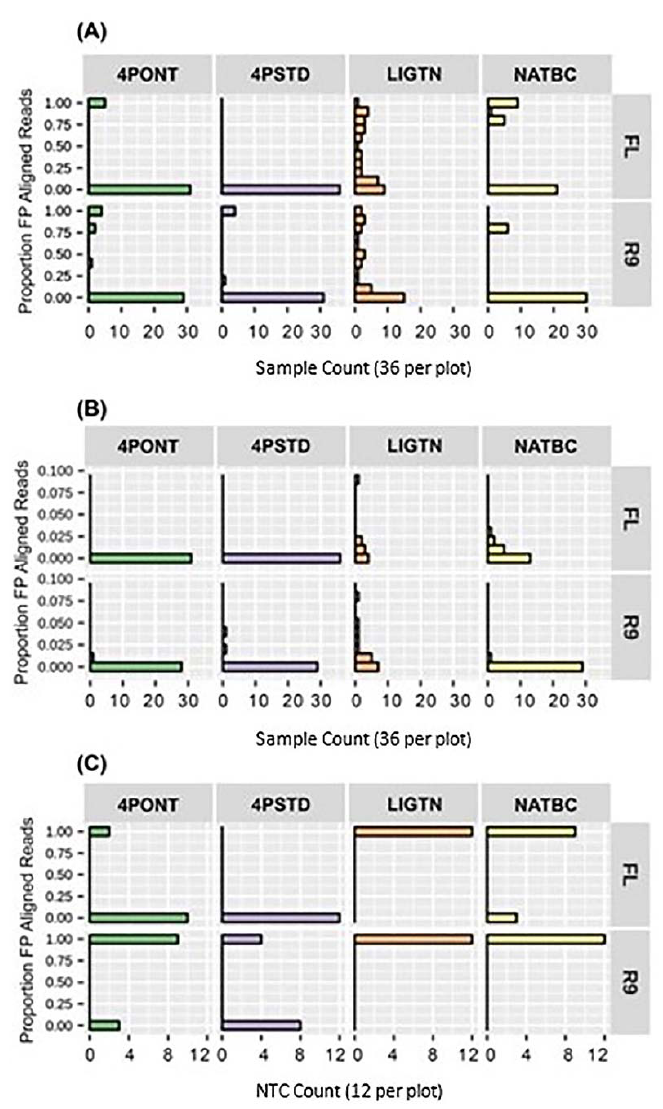
Figure 5. Total FP aligned read counts. Proportion of aligned reads identified as FP after 24 h of sequencing. ( A ) Contains 36 samples per method-flow cell combination, from 0.00 to 1.00 proportion FP. ( B ) A zoom-in of the y-axis of panel ( A ) from 0.00 to 0.10 proportion FP. ( C ) Contains 12 NTCs per method-flow cell combination. Note that panel ( C ) proportions are binary as any aligned read is considered a FP for NTCs.